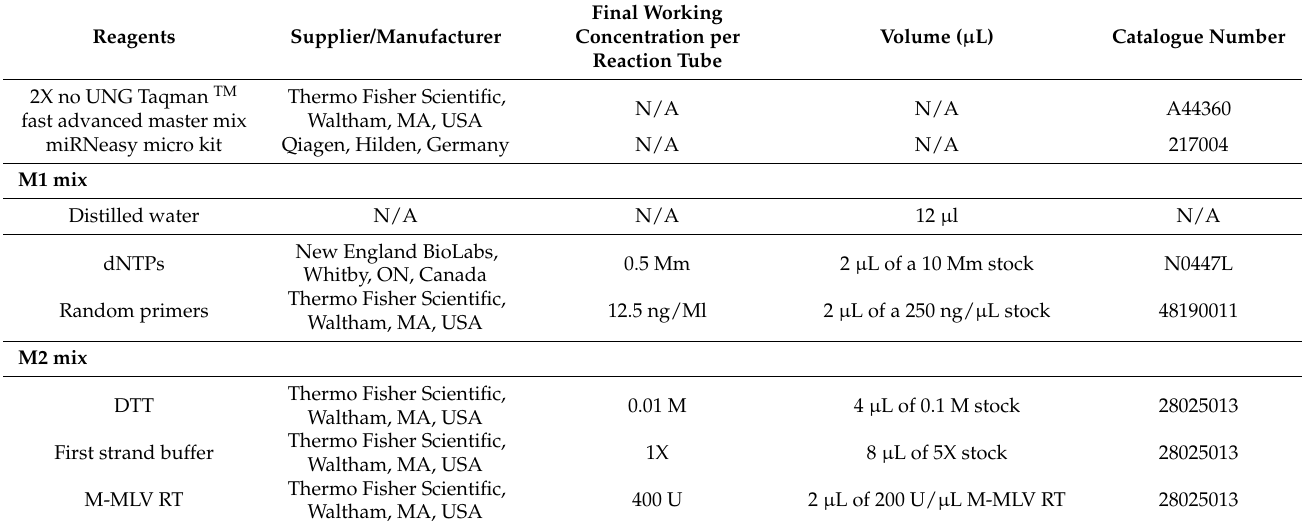
MN spheroid samples are listed in Table 3. The consumables and equipment are listed in Supplementary Table S1. The probes used for the qPCR analysis are listed in Table 4. Table 3. List of reagents .